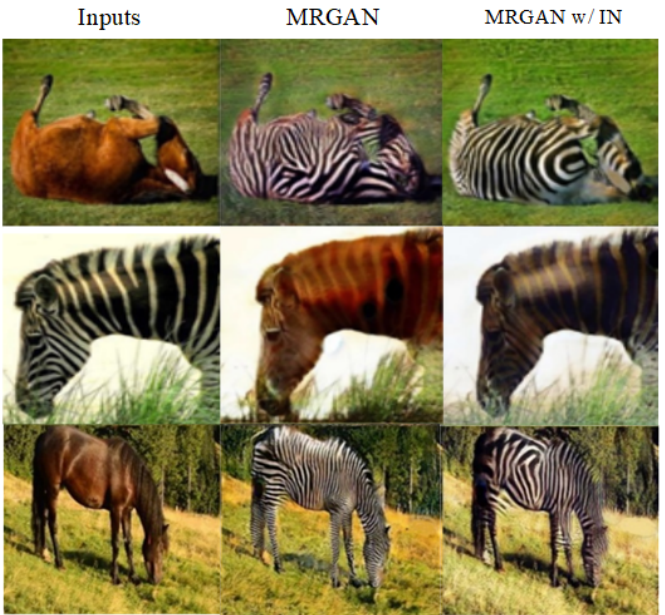
Figure 8. The effects on results using different normalization methods on the object migration between horses and zebras after five rounds. From left to right: input images, the results using the group normalization, and the results using the instance normalization.